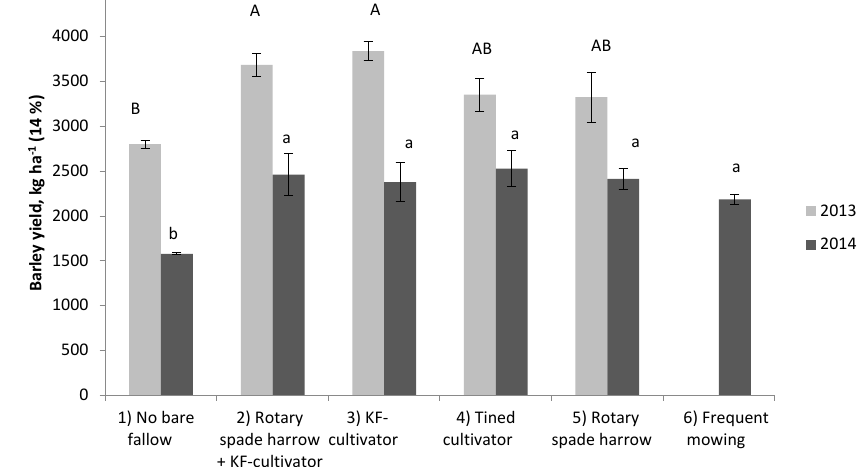
Fig. 4. Average barley yields (kg ha -1 ) in experiment 2 (moisture content 14 %). The location of the experiment was changed yearly. Standard deviations of the treatments are marked with bars (n = 4). The treatments with different letters were significantly different at